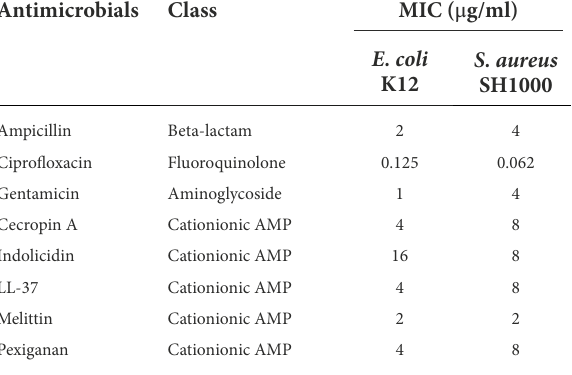
TABLE 1 Minimal inhibitory concentration (MIC) values for Escherichia coli K12 and Staphylococcus aureus SH1000 for different antimicrobials used in this